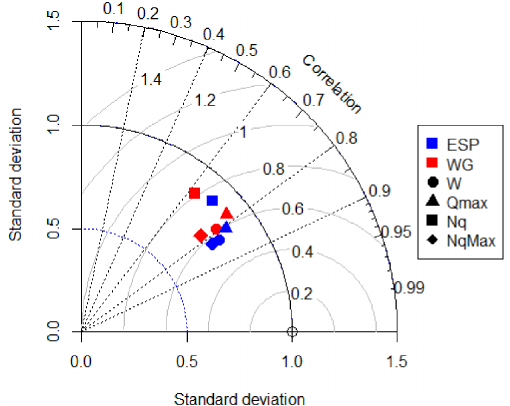
Figure 5. Normalized Taylor diagram of ESP-based (in blue) and WG-based (in red) forecasts of the inflow volume W (circles), the maximum inflow discharge Q max (triangles), the number of days with the inflow discharge above the mean N q (squares) and the number of days with the inflow discharge above the maximum N q max